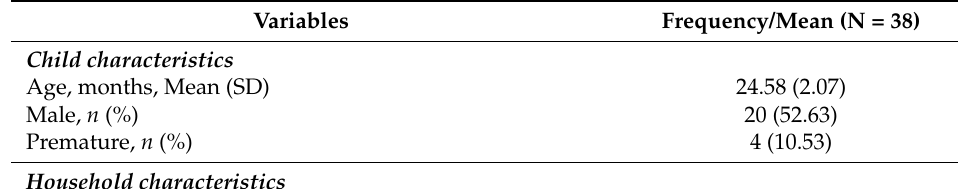
Table 1. Descriptive statistics of child and household characteristics (N =